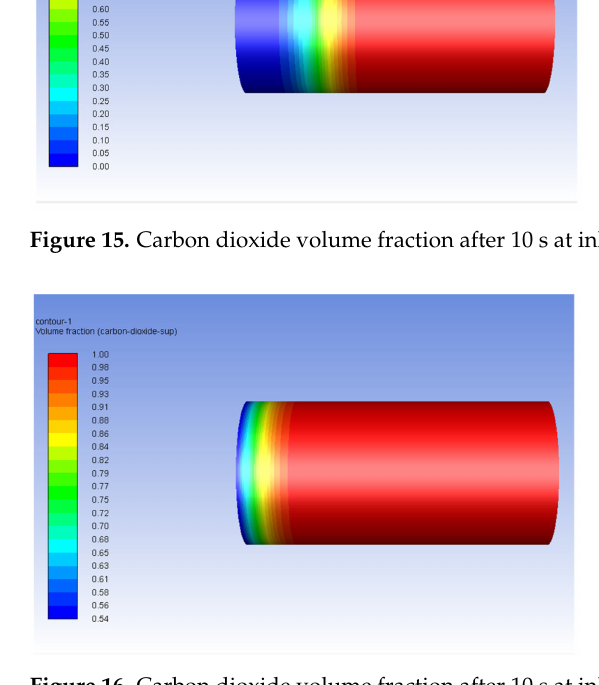
Figure 16. Carbon dioxide volume fraction after 10 s at inlet pressure of 20.2 MPa. Figures 17 and 18 show the relative permeability curves of supercritical carbon dioxide and water at 10.1 MPa and 20.2